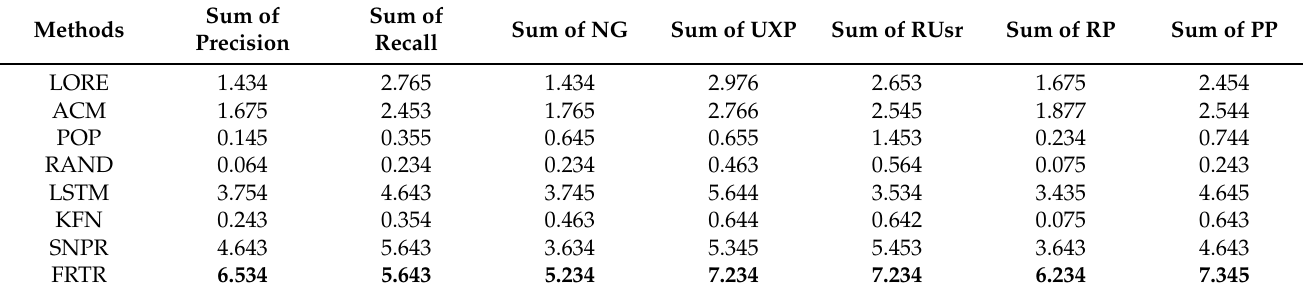
Table 5. Represents the experimental outcomes for the United Kingdom after Sru = 4, Sn = 3, Ns = 50.